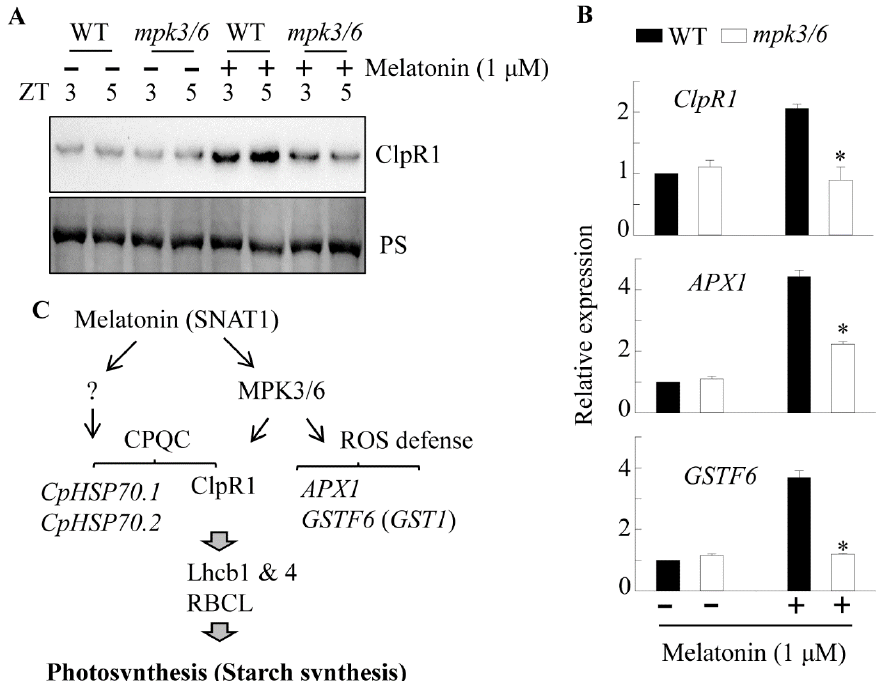
Figure 8. ( A ) Induction of ClpR1 in the WT and mpk3/6 -double knockdown plants in response to melatonin. To eliminate light interference in target gene induction, Arabidopsis leaves were infiltrated with 1 µ M melatonin at ZT0 and transferred to dim light (7 µ mol m − 2 s − 1 ) conditions for 3 h (ZT3) and 5 h (ZT5) before sample harvest. Ponceau S stained blots were used as the loading control. ( B ) Gene expression analysis of ClpR1, APX1 , and GST1 after treatment with 1 µ M melatonin in the WT and mpk3/6 lines at ZT5. ( C ) Proposed model of melatonin-mediated CPQC in Arabidopsis. Asterisks denote significant differences as determined by post hoc Tukey’s HSD test at p < 0.05.